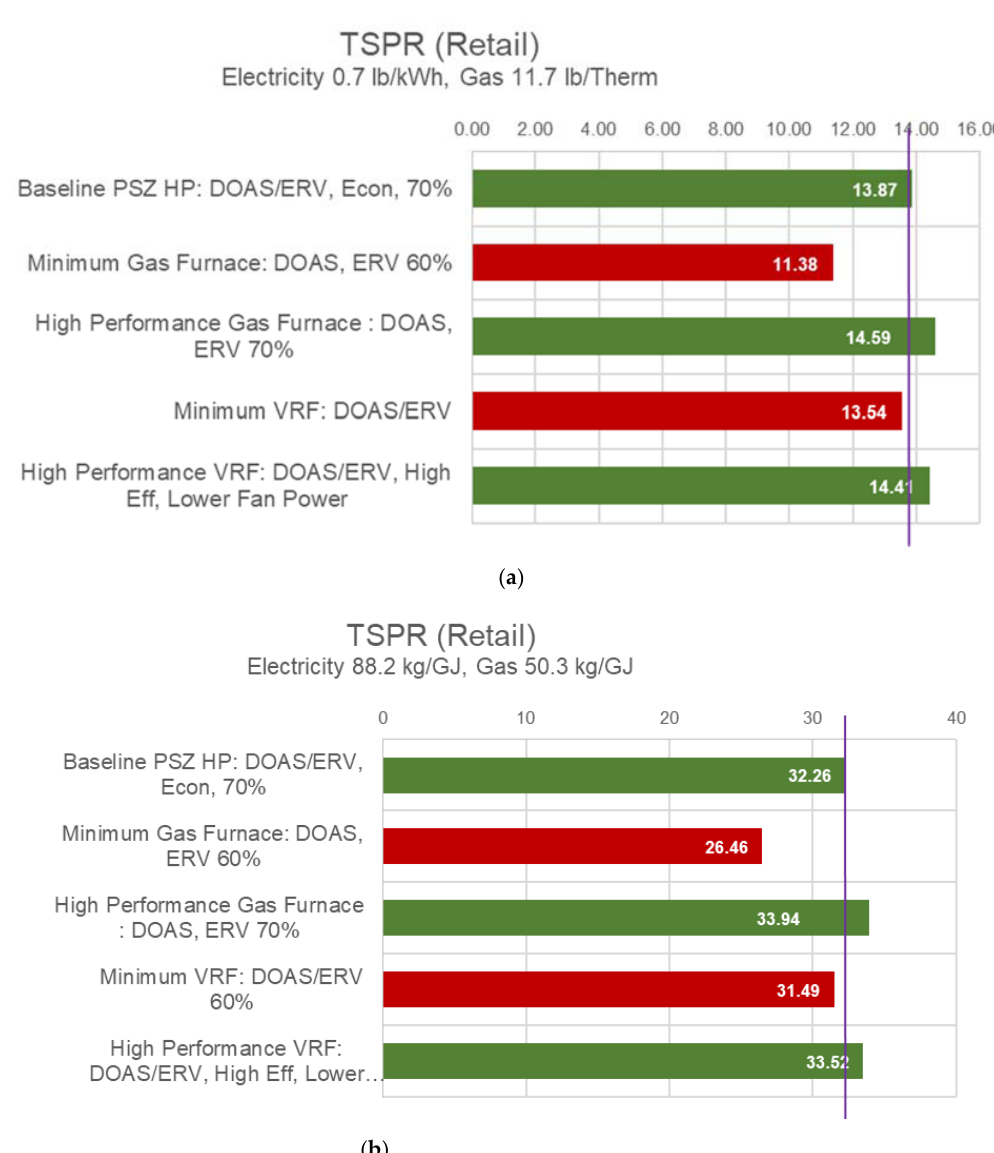
Figure 8. Results for a retail building analyzed using TSPR tool. ( a ) IP units; ( b ) SI units.